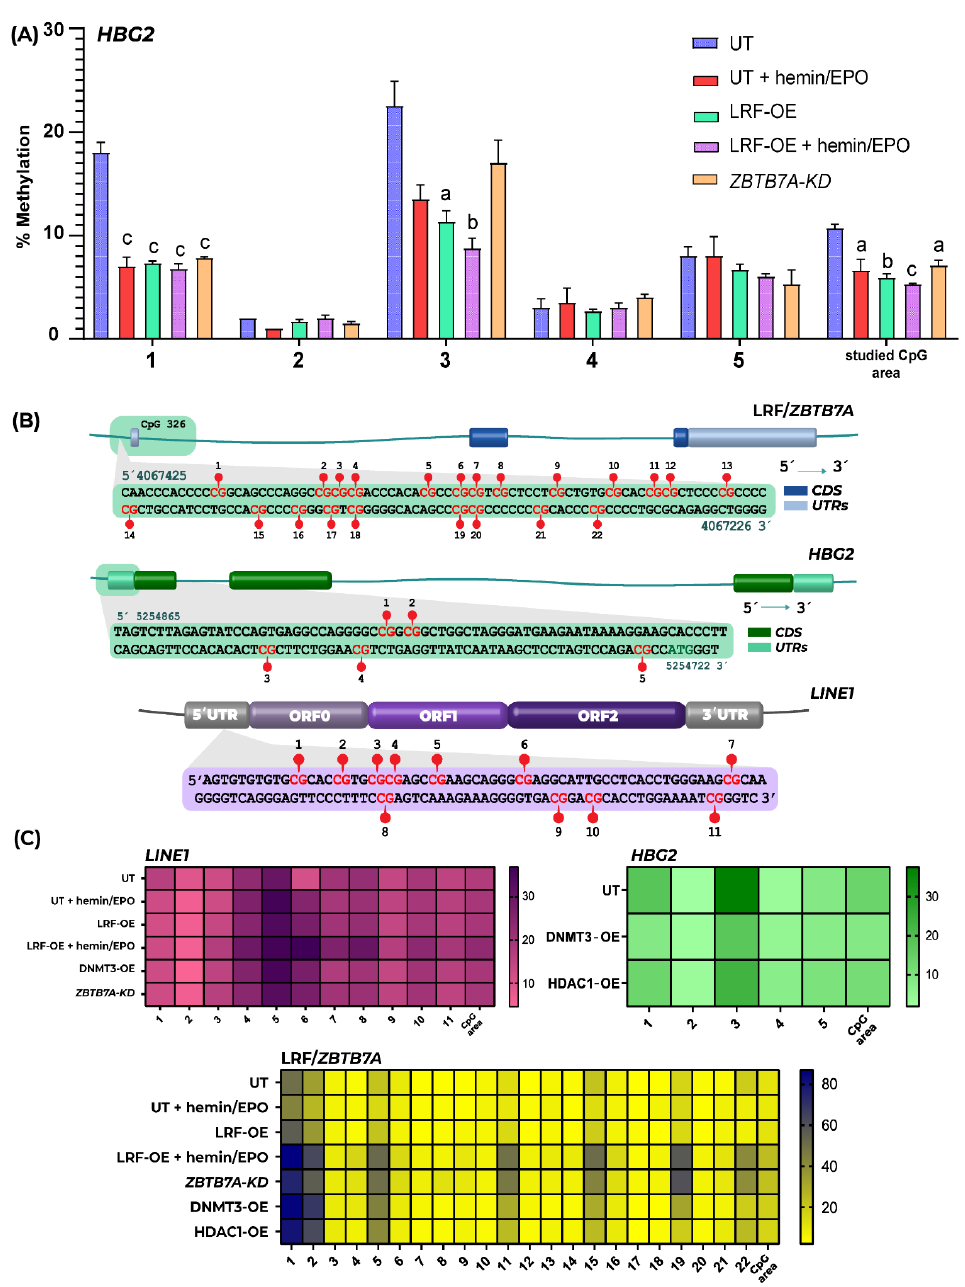
Figure 2. Methylation pattern of CpGs at HBG2 , LRF/ ZBTB7A and LINE1 genetic loci. ( A ) The methylation levels of specific CpG sites lying at the 5 ′ prime end of HBG2 gene. Data are presented as mean ± SE, a indicates p < 0.05, b indicates p < 0.01 and c indicates p < 0.001. ( B ) Schematic representation of HBG2 and LRF/ ZBTB7A gene loci and the LINE1 transposable element. The detailed genomic positions and CpG dinucleotides analyzed are presented. ( C ) Heatmap visualization of the Cytosines’ methylation levels of CpG sites within HBG2 and ZBTB7A promoter regions and 5′ UTR of LINE1 . Methylation status of the whole CpG area in each locus is also depicted. Each square corresponds to one CpG site analyzed; data are presented as mean percentage methylation.